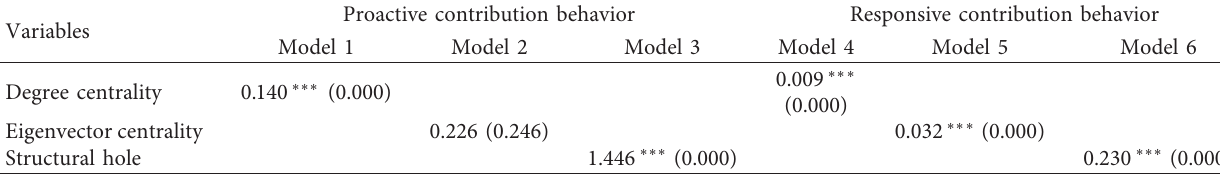
Table 5: The regression results of hypothesis